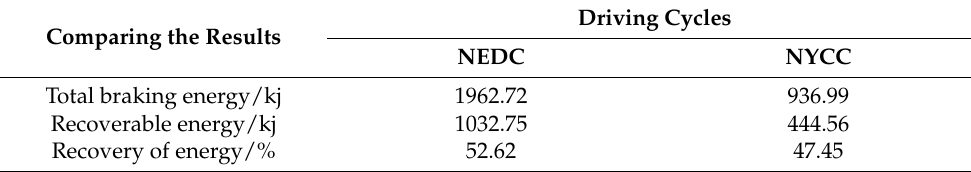
Table 3. The results of finite element